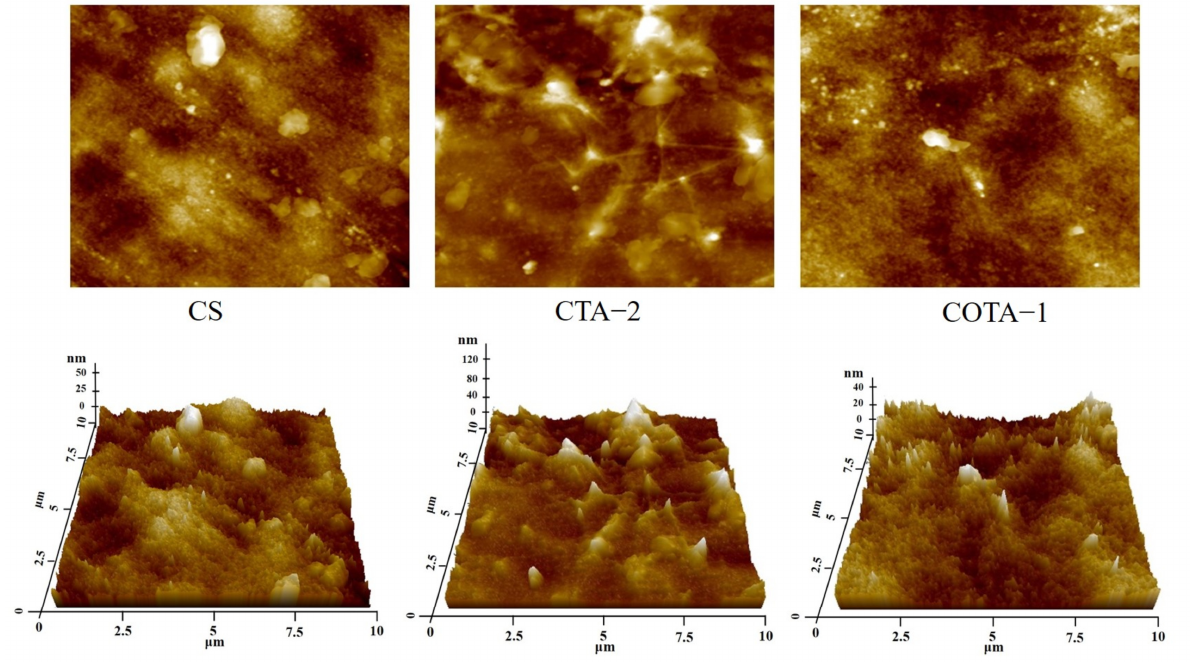
Figure 10. AFM height images and 3D topography for CS, CTA ‐ 2, and COTA ‐ 1 films. Table 4. Roughness parameters obtained from AFM analysis of CS, CTA-2, and COTA-1 films.